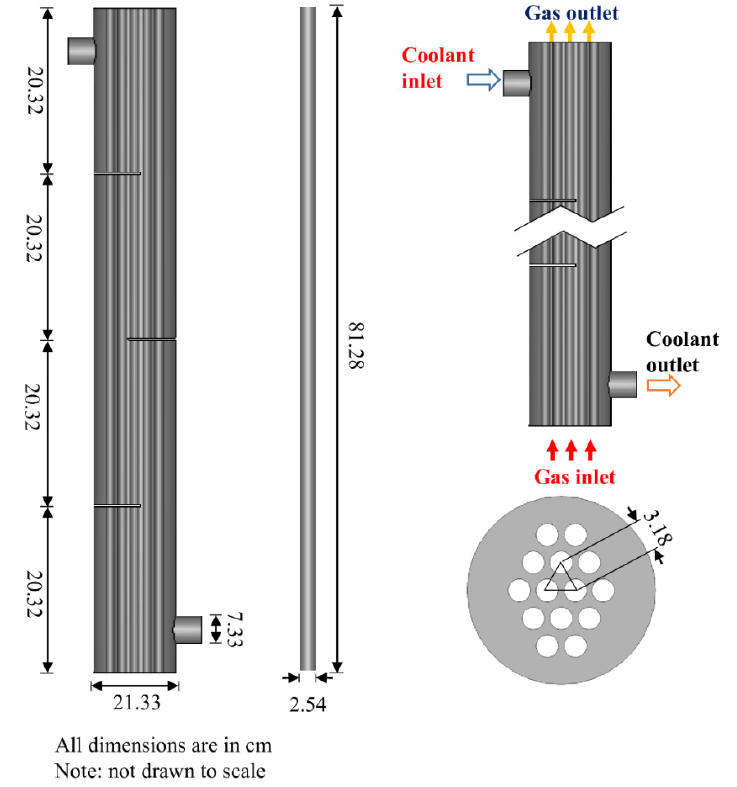
Figure 1. 3D multi-tubular reactor model. Figure 1. 3D multi ‐ tubular reactor model. Table 2. Geometric dimensions of the multi-tubular